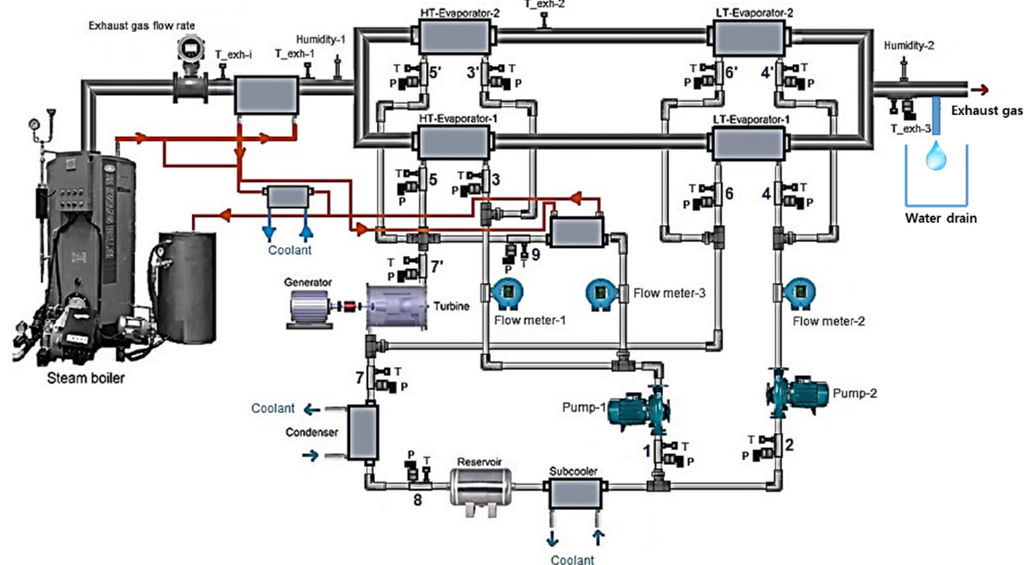
Figure 2. Schematic of the experimental setup of the WHWR system.